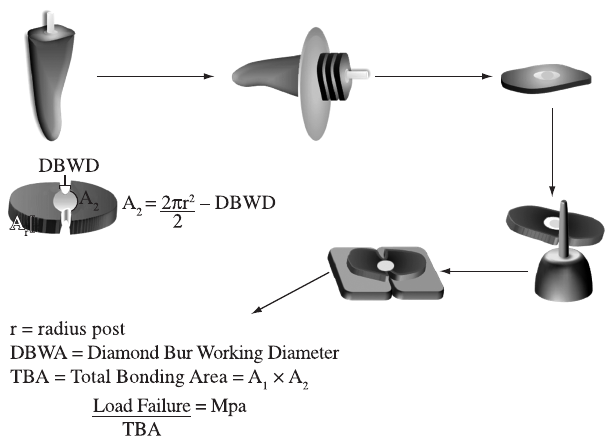
Figure 1. Schematic of formation’ slices to microtensile test and conversion of Newton to Mpa data.